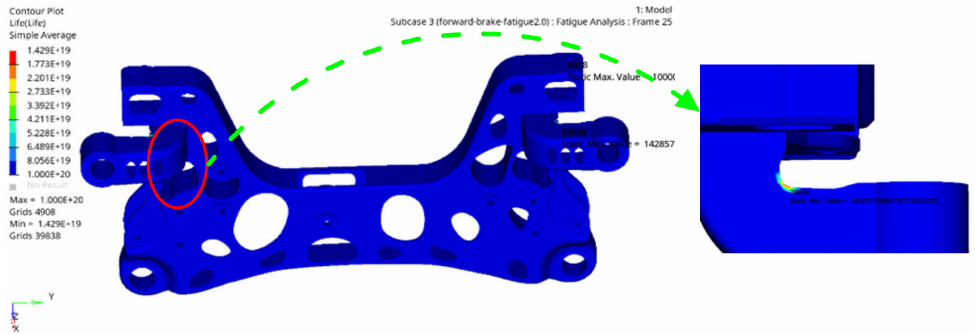
Figure 22. Fatigue life cloud diagram of aluminium alloy front subframe under forward braking